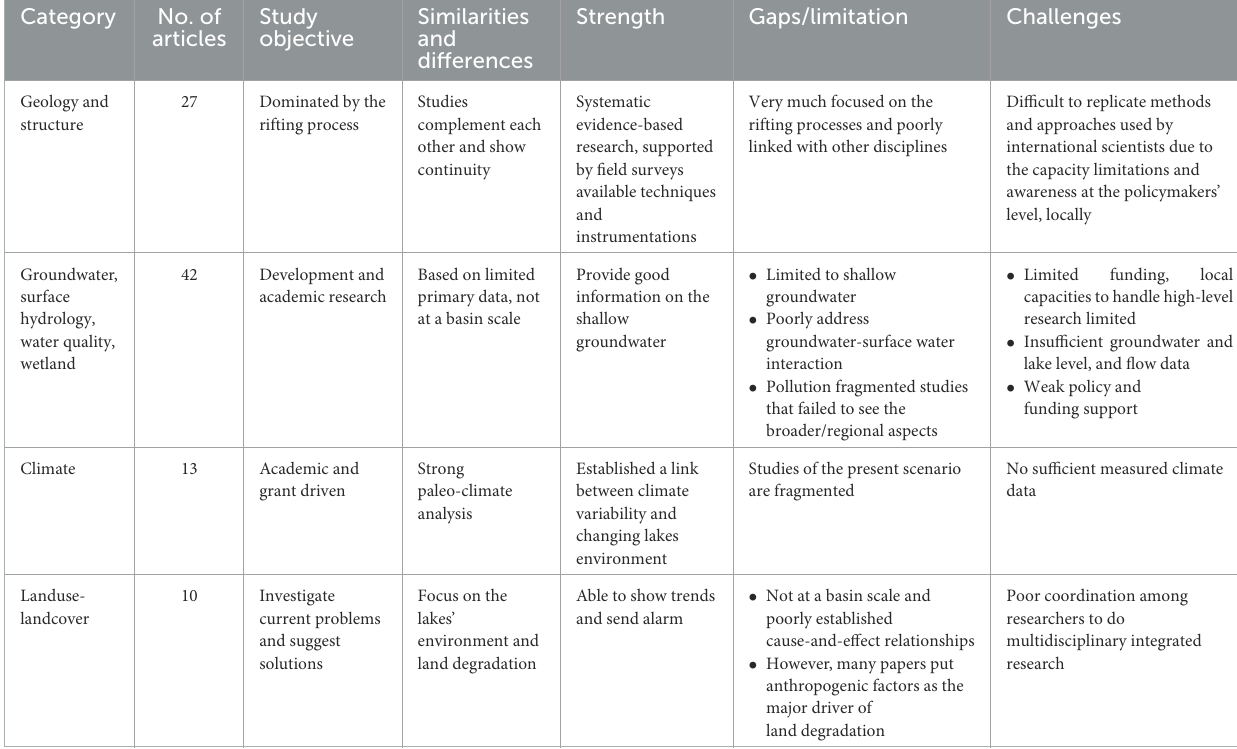
TABLE 2 Major gaps and challenges in groundwater water and related research in the